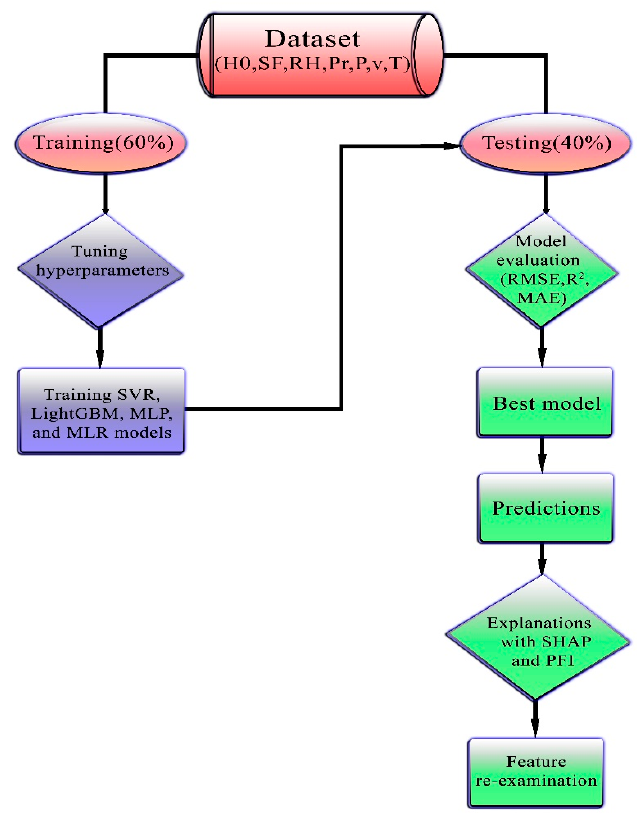
Figure 4. Flowchart of the methodology used in this study.